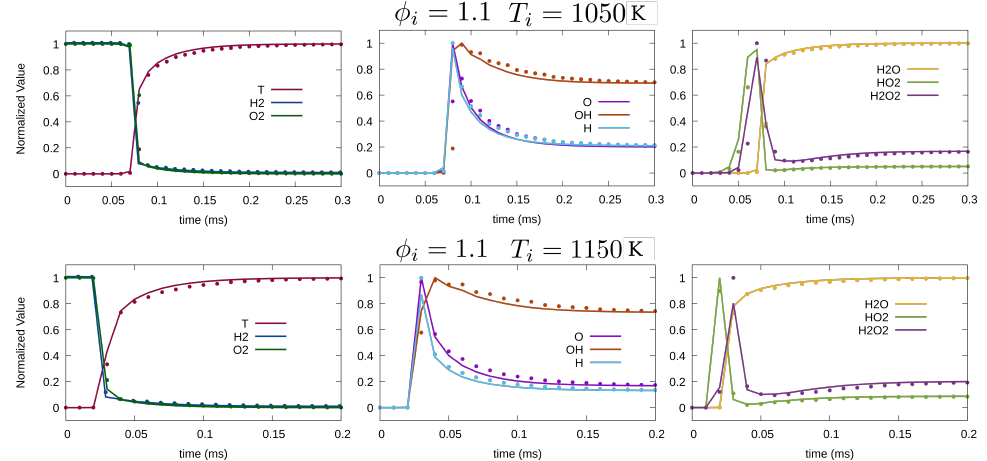
Figure 5. Temporal variation of normalized temperature and species mass fraction for φ i = 1.1, T i = 1050 K ( top ), and T i = 1150 K ( bottom ). Solid line and symbols represent OpenFOAM and LIT solution,